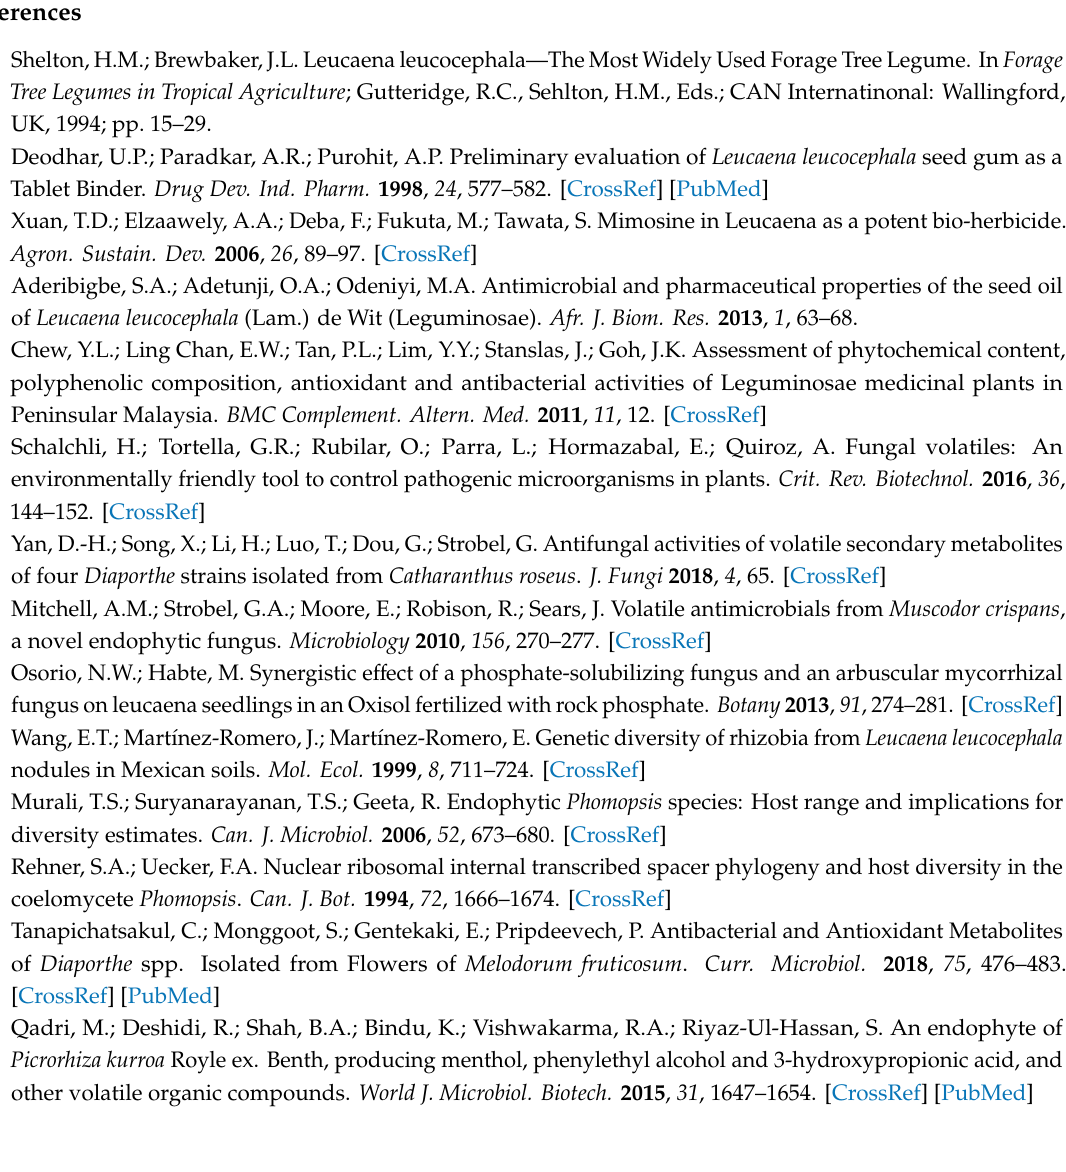
Figure S1: Phylogenetic tree from a MP analysis based on the combined genes dataset (ITS, CAL , HIS , TEF1 , TUB ), Table S1: Classification of volatile compounds produced by Diaporthe apiculatum strain FPYF 3052, Table S2: The pair primers for amplifying ITS, CAL, HIS, TEF1 , and TUB sequences, Table S3: The reference taxa of Diaporthe species with sequences information were downloaded from NCBI nucleotide